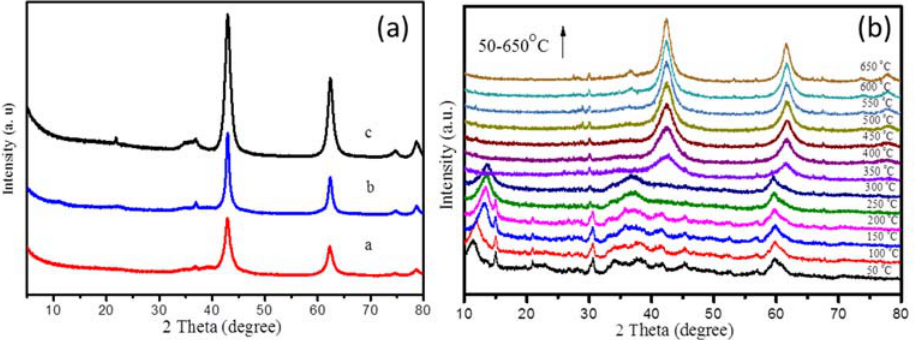
Figure 8. ( a ) X ‐ ray diffraction patterns of PtSn/Mg(Al)O with different Mg:Al molar ratios: a: Mg:Al = 2:1; Figure 8. ( a ) X-ray diffraction patterns of PtSn/Mg(Al)O with different Mg:Al molar ratios: a: b: Mg:Al = 5:1; c: Mg:Al = 10:1. ( b ) In situ X ‐ ray diffraction patterns of Mg(Al)O (Mg:Al = 5:1) LDH at Mg:Al = 2:1; b: Mg:Al = 5:1; c: Mg:Al = 10:1. ( b ) In situ X-ray diffraction patterns of Mg(Al)O temperatures between 50 and 650 °C. (Mg:Al = 5:1) LDH at temperatures between 50 and 650 ◦